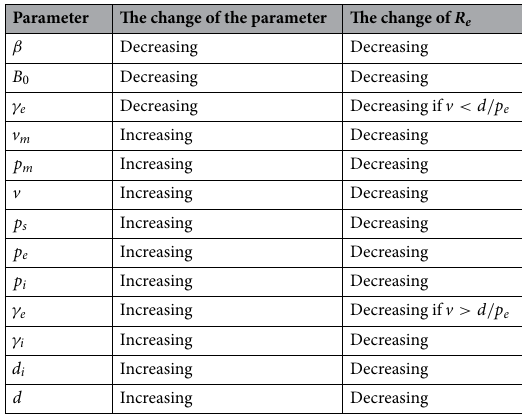
Table 2. The effect of parameter on the effective reproduction